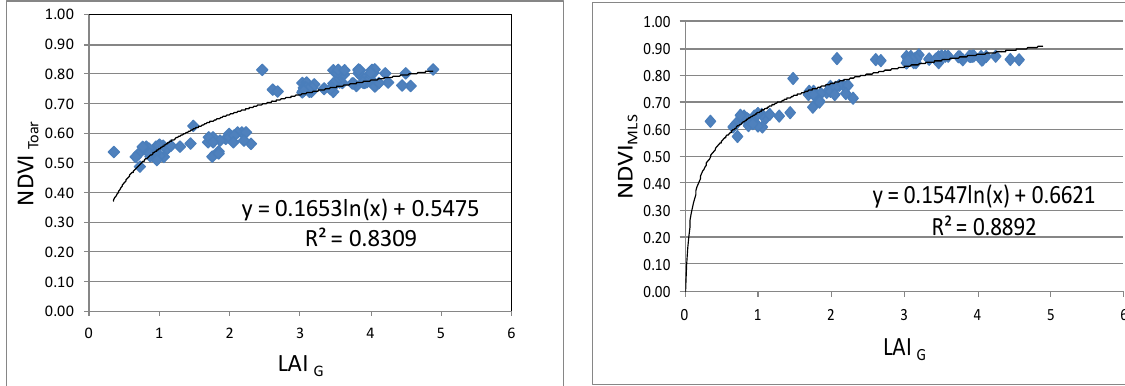
Figure 3: Relationship of LAI G and NDVI TOAR for corn crop Figure 4: Relationship of LAI G and NDVI MLS for corn